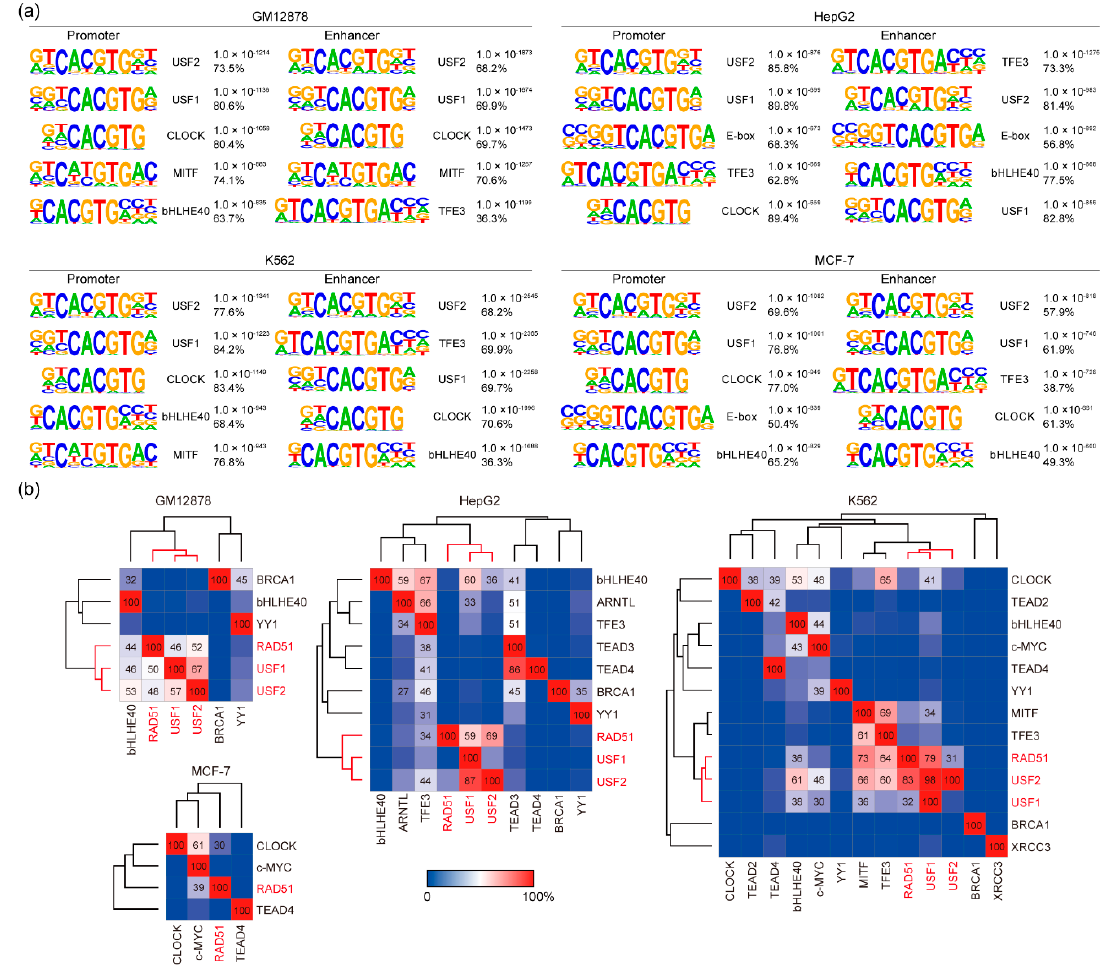
Figure 2. Motif analysis of genome-wide RAD51 binding sites in GM12878, HepG2, K562, and MCF-7 cell lines. ( a ) The top five motifs identified in each set of RAD51 binding sites are shown. ( b ) Heatmaps show the percentage of co-occupancy between given proteins. The percentage was calculated by dividing the number of co-occupied sites by the total number of binding sites on a given protein (row). Hierarchical clustering based on the co-occupancy percentage was conducted using the average-linkage method with the one-minus Pearson correlation metric.